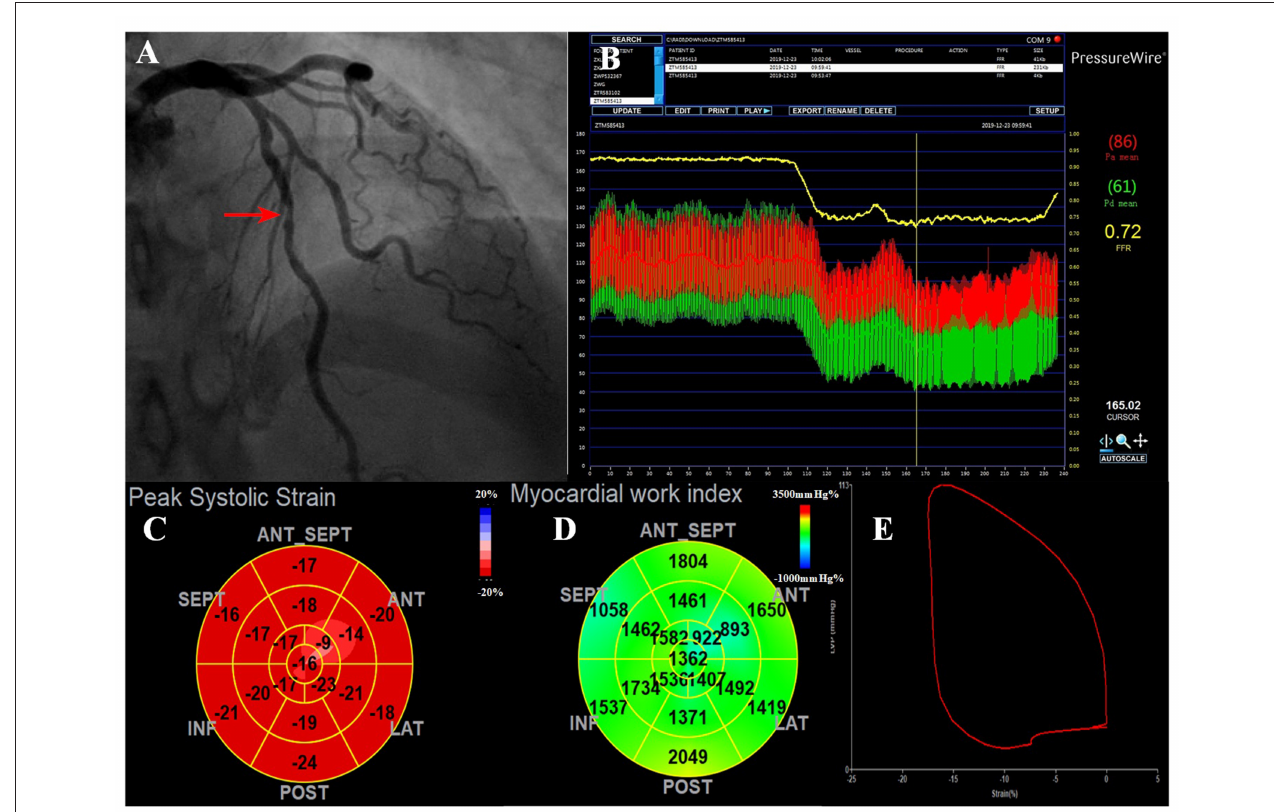
FIGURE 1 | A representative case of the ischemic LAD with intermediate stenosis. (A) Invasive coronary angiogram demonstrates 50% narrowing in the LAD (red arrow). (B) The corresponding FFR value was 0.72, which was below the ischemic threshold of 0.75, indicating a functionally significant stenosis. (C) The bull’s eye plot shows decreased peak systolic longitudinal strains in the apex-anterior, mid-anterior segments. (D) MWI values were impaired mostly in the anterior wall (supplied by the LAD). The regional MWI was 1,411.62 mmHg% and MCW was 1,686.62 mmHg%. (E) LV pressure-strain loop diagram. FFR, fractional flow reserve; LAD, left anterior descending; MCW, myocardial constructive work; MWI, myocardial work